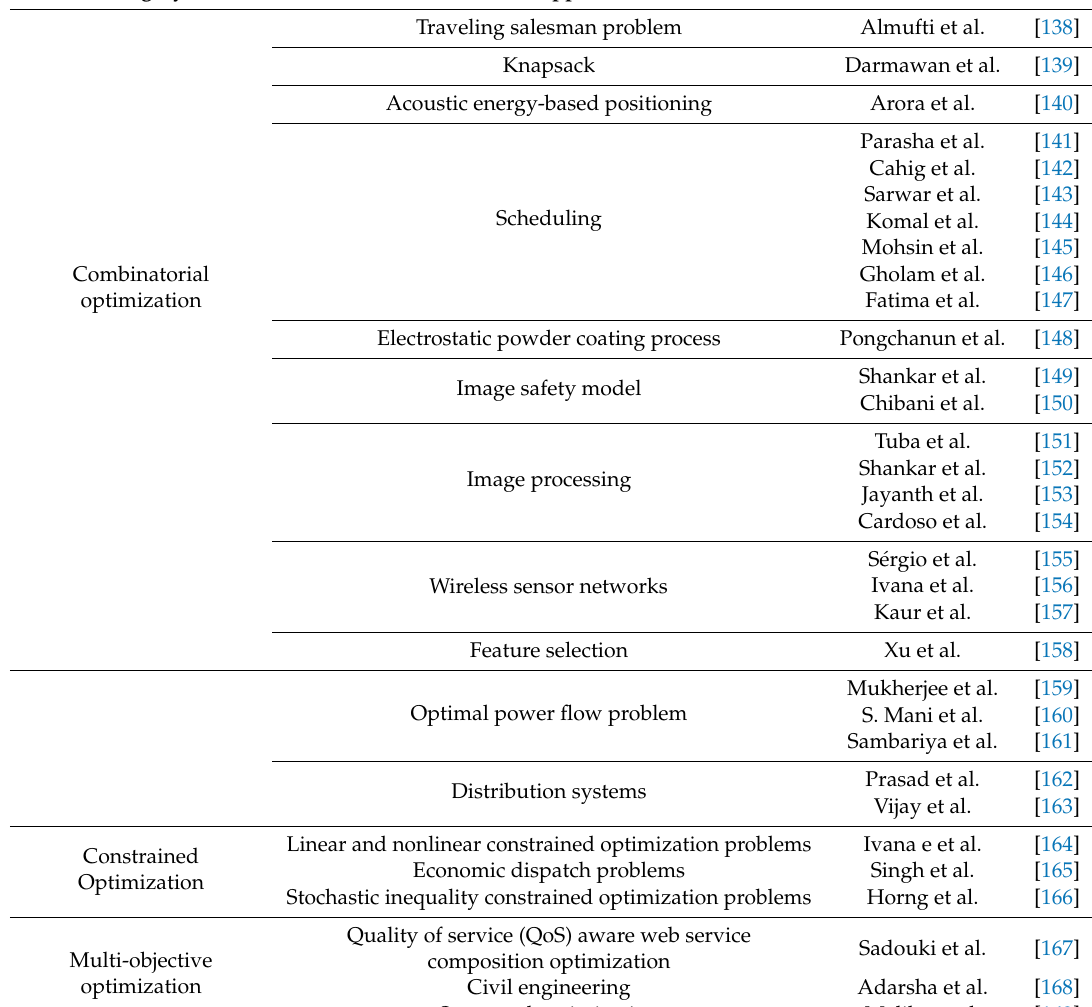
Table 5. A summary of the EHO applications in engineering